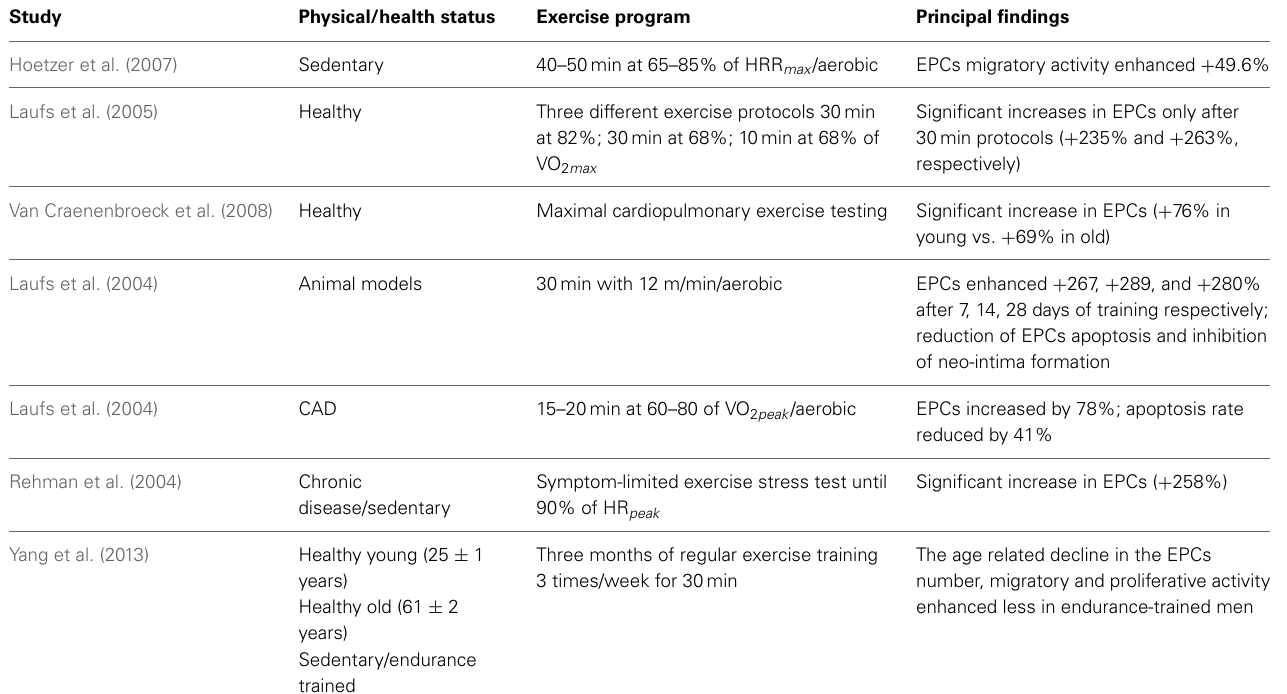
Table 1 | Summary of the studies reporting the exercise induced effects on EPCs, in animal and human